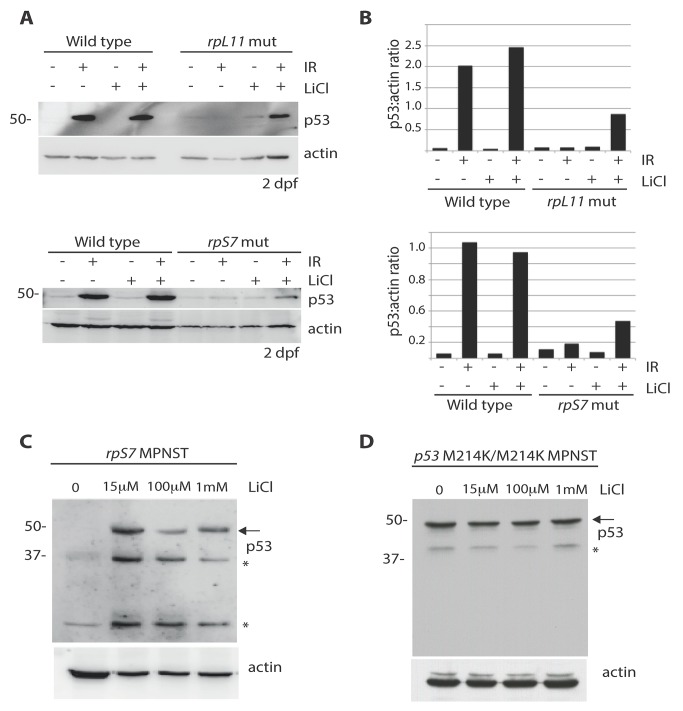
Lithium chloride restores p53 stabilization in RP mutant embryos and tumor cells.
A) Western blot analysis of p53 levels in 2 dpf wild type, rpS7, or rpL11 mutant embryos either untreated or exposed to 25 Gy ionizing radiation followed by the addition of 100μM LiCl. Note the partial rescue of p53 stabilization in the RP mutant embryos when exposed to LiCl after IR. B) Quantification of the p53:actin ratio of the western blots from (A). C) Western blot analysis of p53 levels in rpS7 MPNST tumor cells untreated or incubated with varying concentrations of LiCl. D) Western blot analysis of p53 levels in p53
M214K/M214K MPNST tumor cells untreated or incubated with varying concentrations of LiCl. * indicates either a p53-specific isoform or a degradation product.